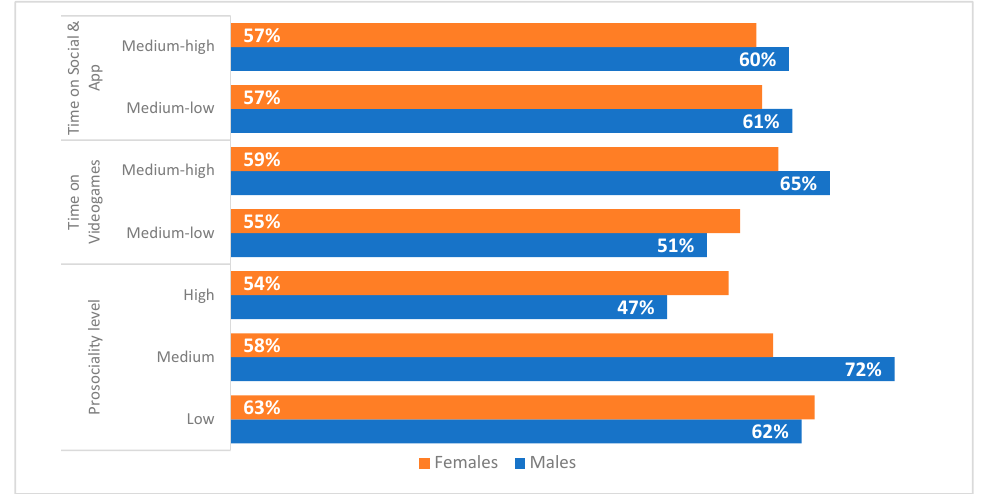
Figure 5. Levels of adherence to male gender roles by sex (% of medium and high levels by prosociality, screen time playing videogames and screen time spent on social media and applications).